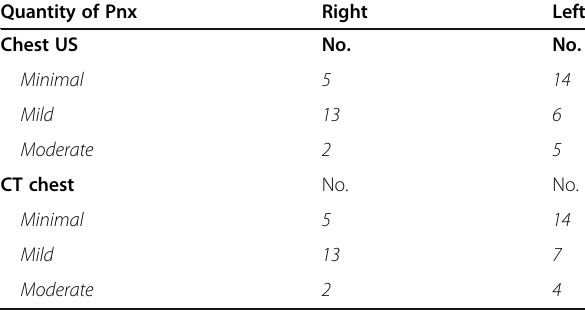
Table 4 Quantification of the size of traumatic PTx by chest US and CT